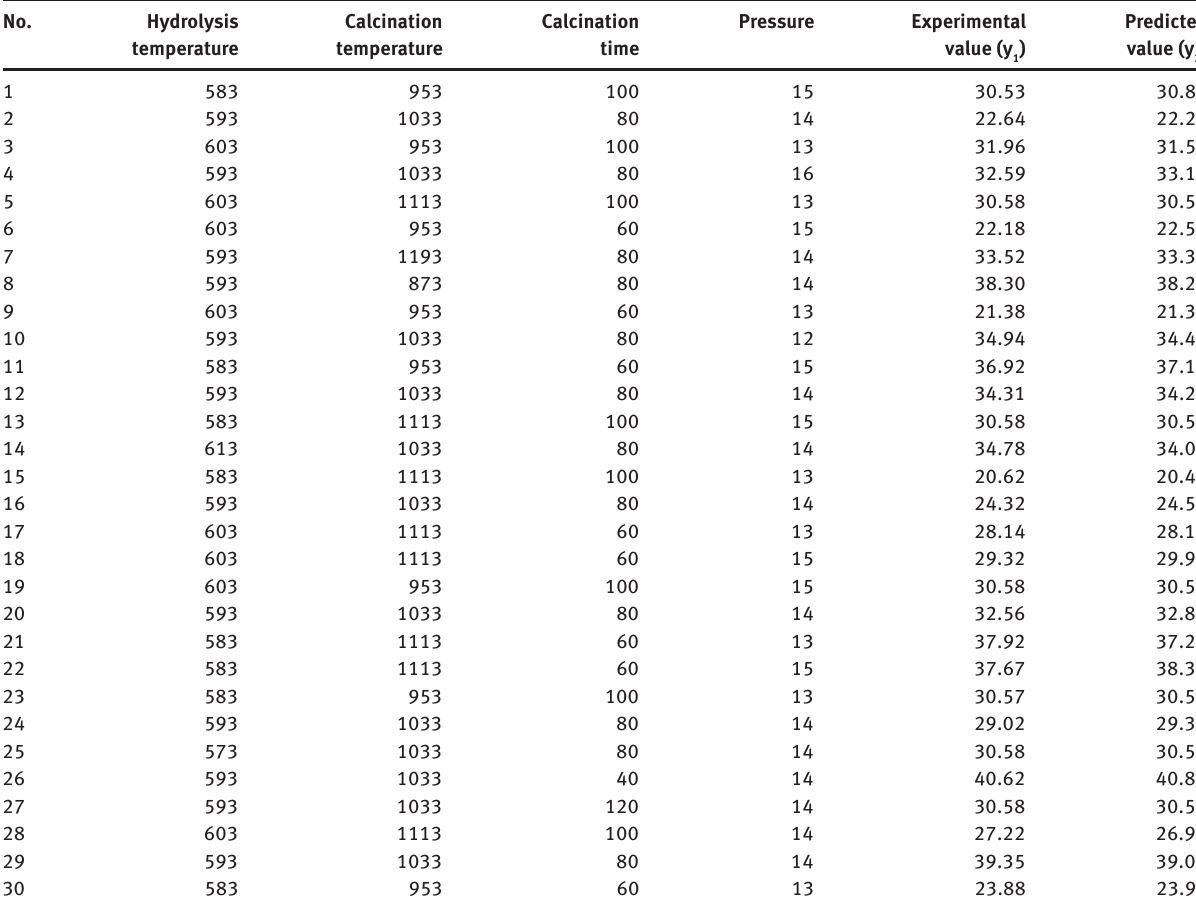
nanocrystallites. 2